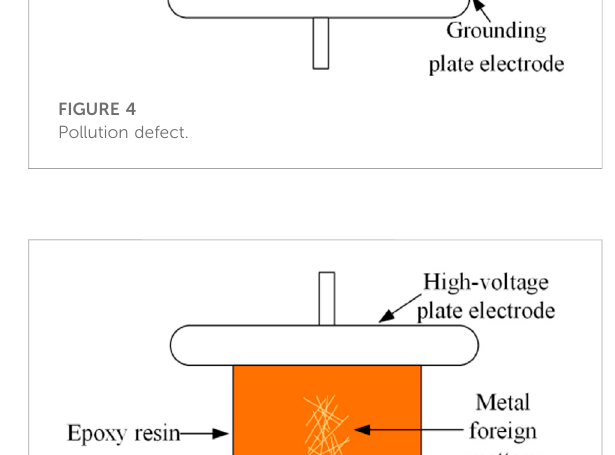
FIGURE 3 Metal burr defect.